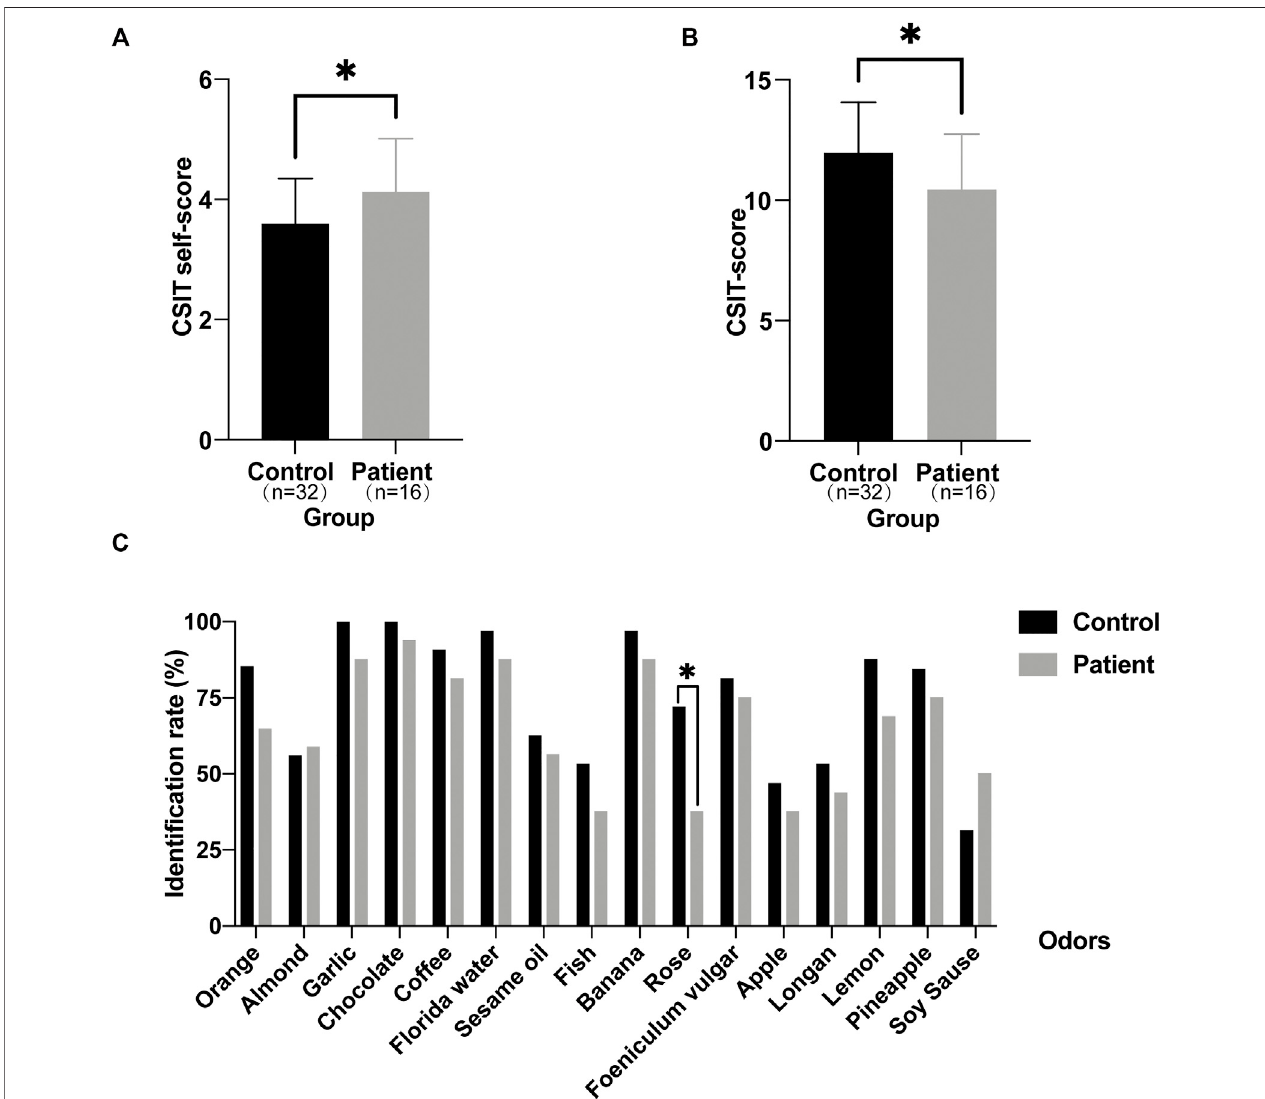
FIGURE 4 | Olfactory assessment in ALMS patients and controls. (A) The CSIT self-scores of ALMS patients and controls. (B) The tested CSIT scores of ALMS patients and controls. (C) The identi fi cation rate of each odor in ALMS patients and controls. * p < .05.